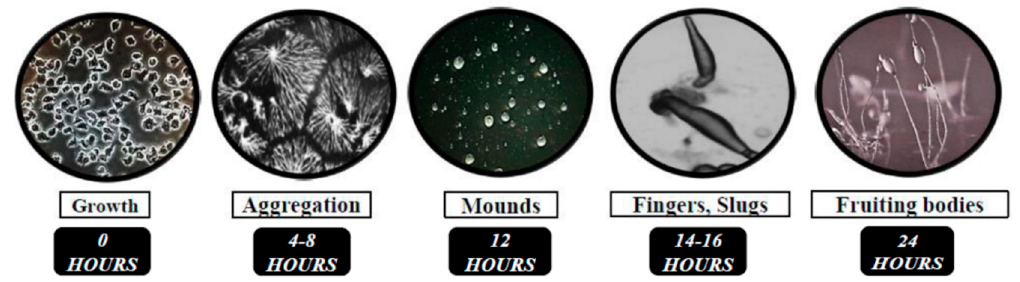
Figure 1. The 24-h life cycle of Dictyostelium discoideum . In nutrient-rich conditions, Dictyostelium grow as single cells and feed on readily available nutrients and bacteria. Removal of the food source initiates multicellular development. During the initial stages of development, cells chemotactically aggregate towards 3 (cid:48) ,5 (cid:48) -cyclic adenosine monophosphate (cAMP) to form multicellular mounds. Cells then undergo a series of structural changes to form a finger followed by a motile pseudoplasmodium, or slug. Finally, the majority of cells within the slug terminally differentiate to form either stalk cells or spores in a fruiting body. Spores are dispersed and then germinate when nutrients become available, restarting the life